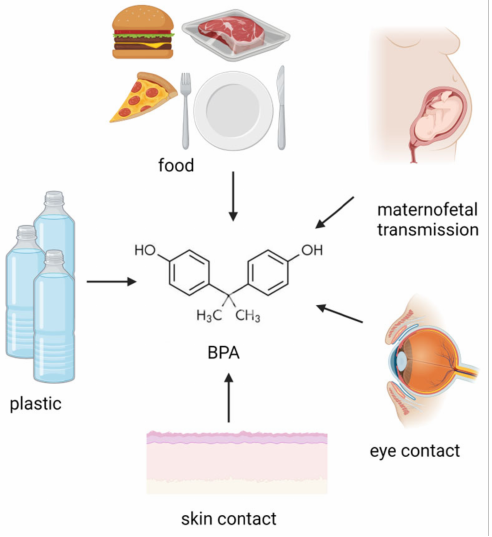
Figure 1. Potential BPA origin. BPA exposure sources involve ingestion, maternofetal transmission, inhalation, skin, and eye contact. (Created with BioRender.com).